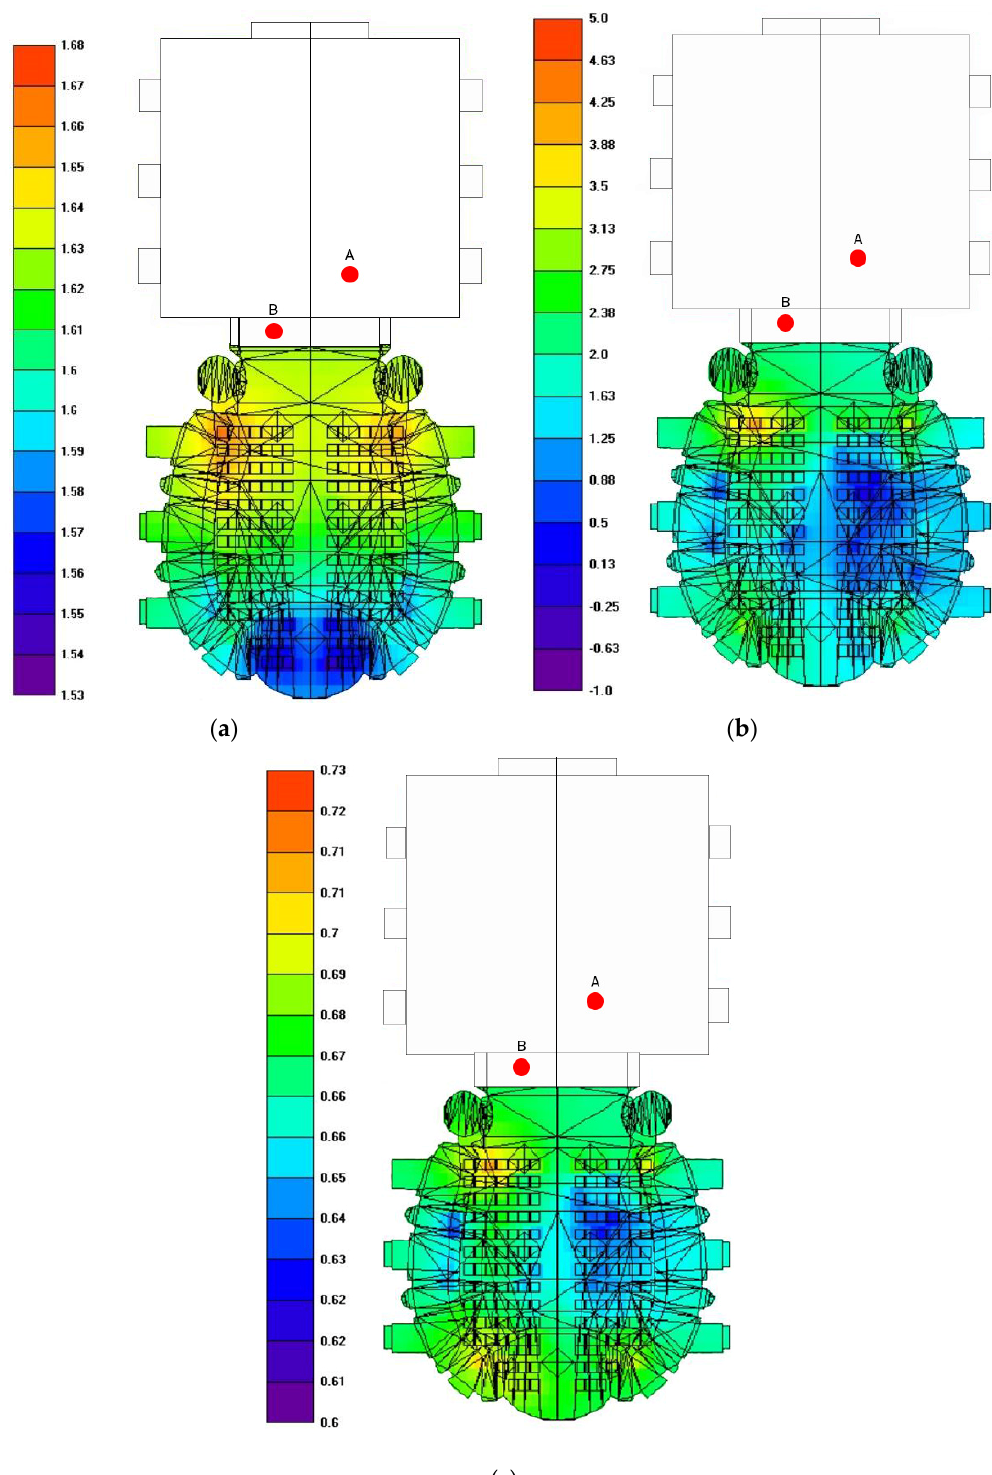
Figure 11. Color maps at 1 kHz of the T30 ( a ), C80 ( b ), and Speech Transmission Index (STI) ( c ) in unoccupied condition and with asymmetrical positions of the sound sources A and B on the stage. At the frequency of 1 kHz, the parameter C80 results around 1.65 dB in the Royal box, confirming